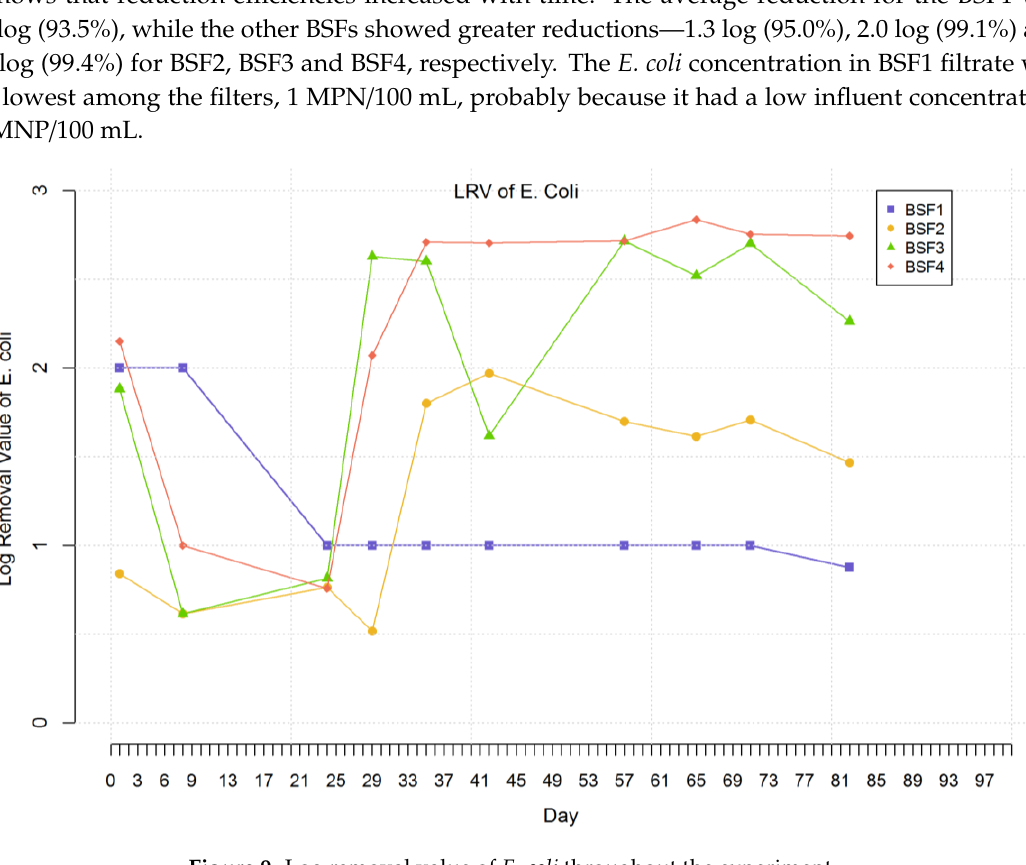
Table 4. Simple effect comparisons of filter ime least squares means by time adjustment for multiple comparisons: Tukey.